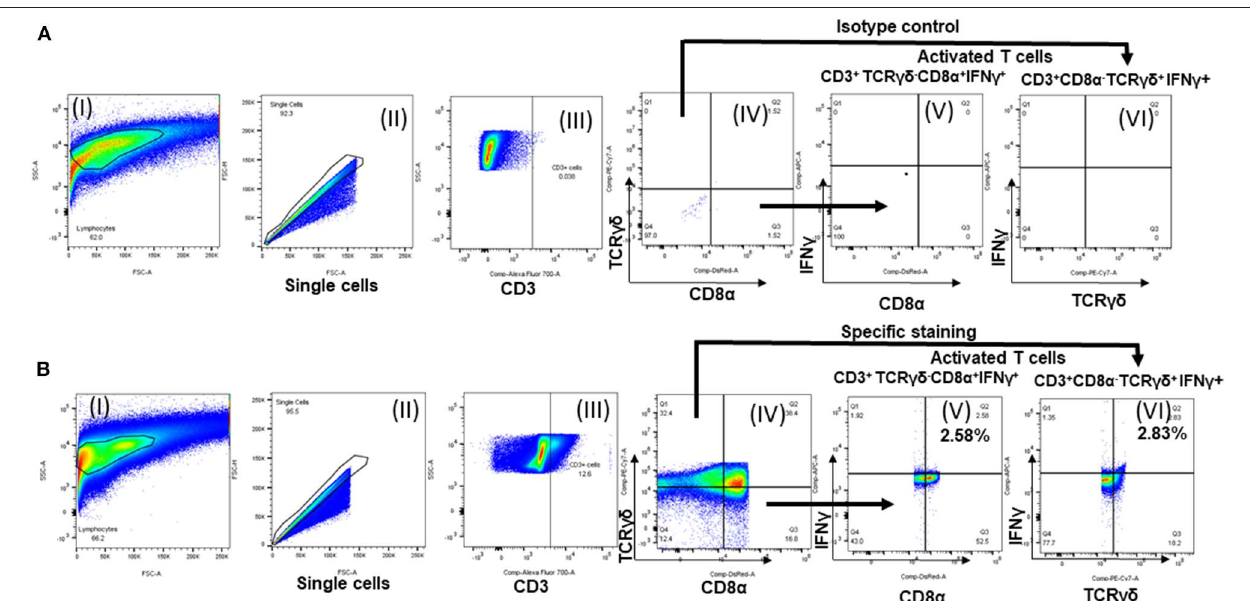
FIGURE 5 | Flow cytometry analysis of splenocytes of vaccinated and challenge birds. Lymphocytes gating strategy followed to show the percentage of specific activated lymphocyte subsets. (A) Isotype control and (B) specific antibody immunostained splenocytes analysis. (I) Lymphocytes gating; (II) single cells selection; (III) cells gated initially for CD3; (IV) subdivided the CD3 + population into TCR γδ + /TCR γδ − and CD8 α + / CD8 α − ; IFN γ + secreting (V) TCR γδ − CD8 α + cells and (VI) TCR γδ + CD8 α −